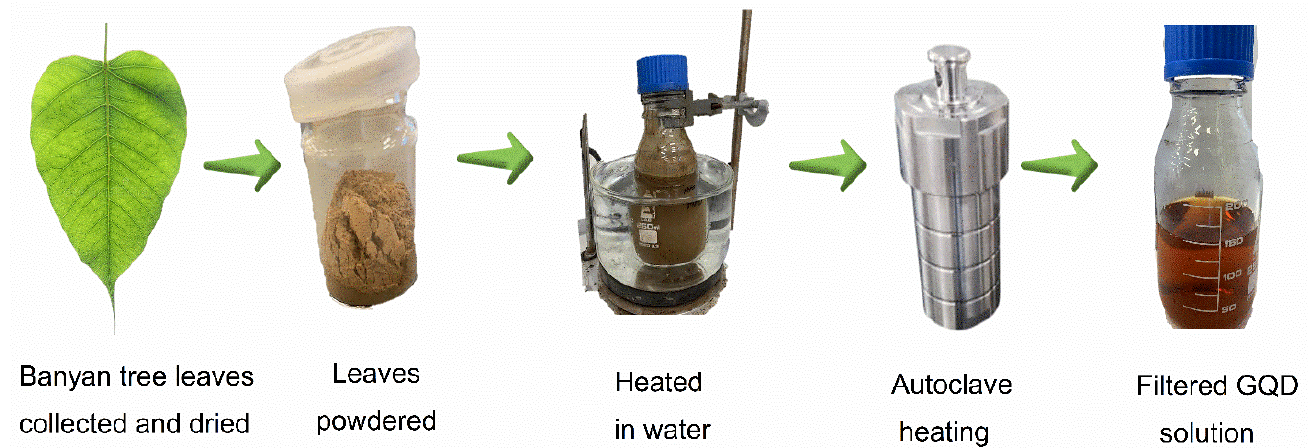
Figure 1. The stages involved in the synthesis of GQD from banyan tree